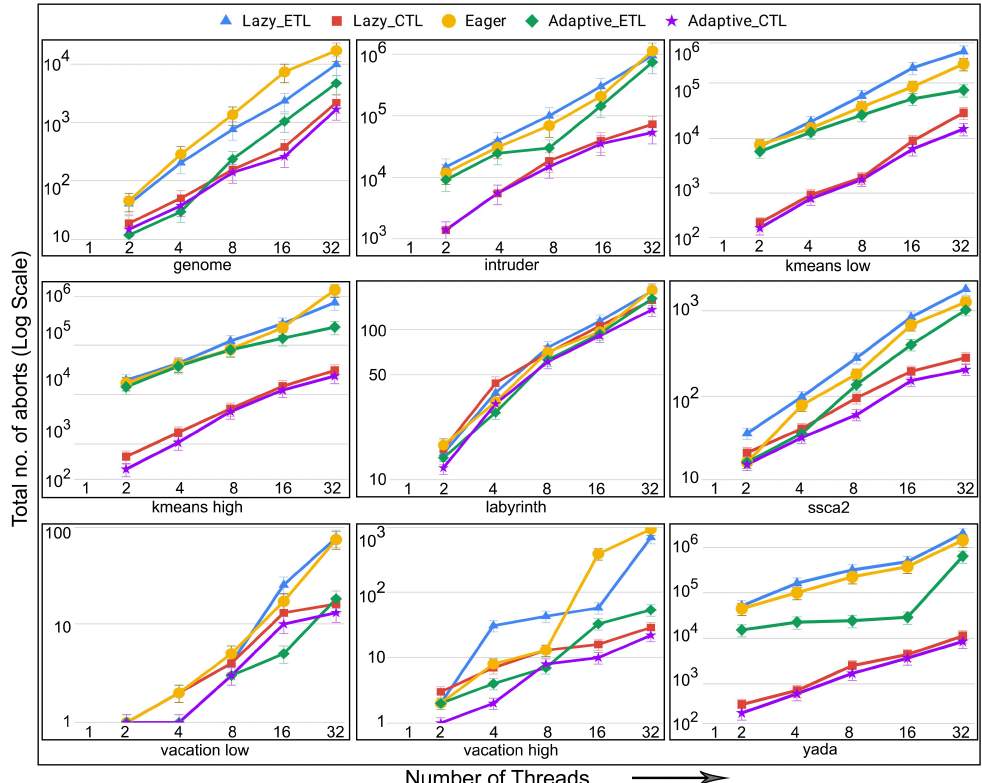
Figure 22. Number of aborts in STAMP benchmarks using better time barrier in non-persistent TM. Results on STAMPEDE Benchmarks. Similar to micro and STAMP benchmarks, A DAP